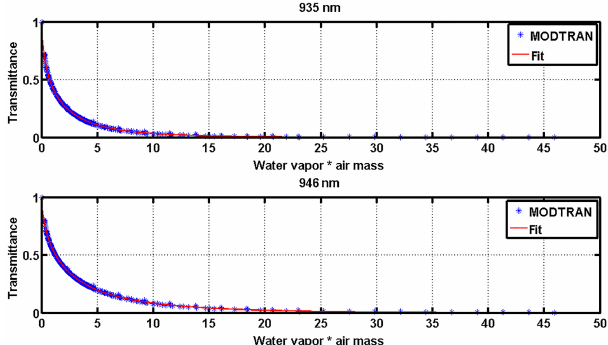
Figure 3. Transmittance of IWV versus slant water vapour path ( m w ∗ u ) calculated by MODTRAN and three-parameter expression fit for 935 and 946nm